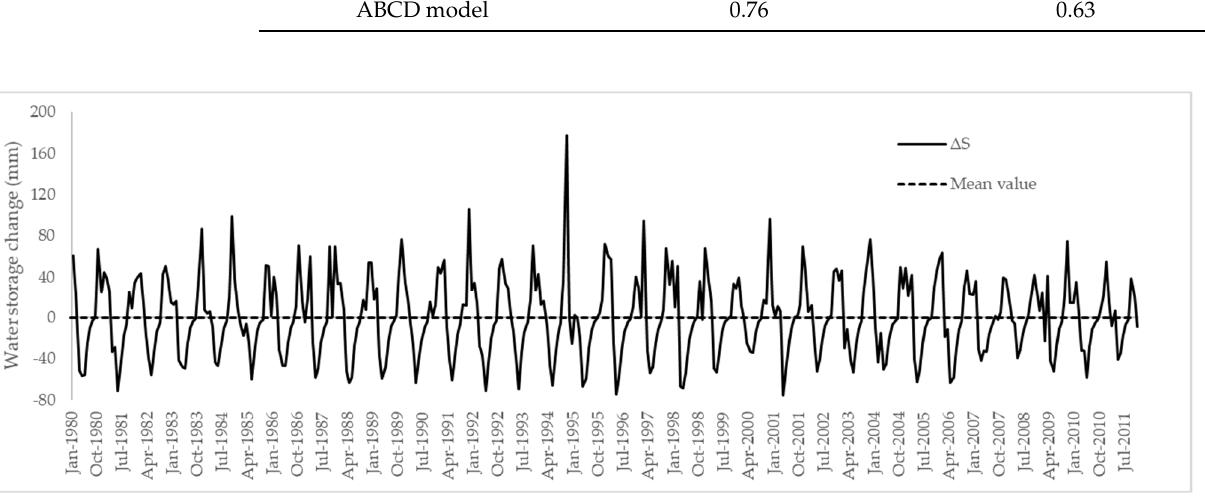
Figure A3. Monthly water storage change in the KRB.